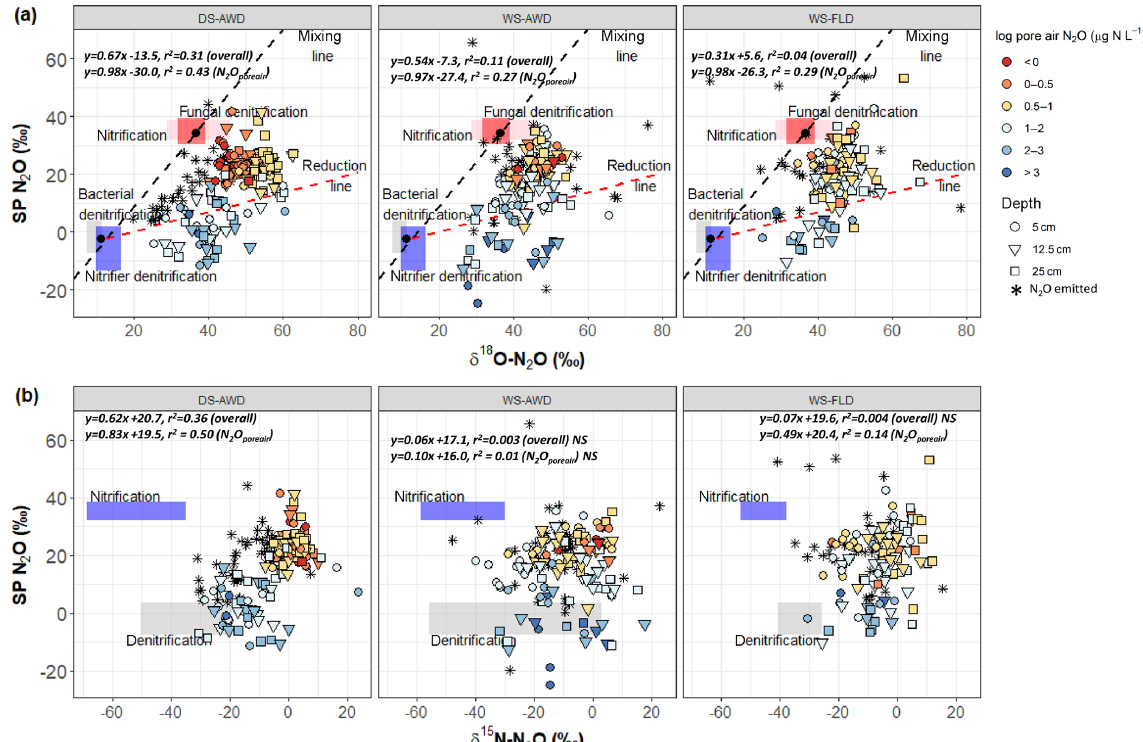
Figure 4. Graphical two end-member mixing plot after Lewicka-Szczebak et al. (2017) where sample values are plotted in SP × δ 18 O − N 2 O space A and two-end mixing plot after Toyoda et al. (2011) where sample values are plotted in SP × δ 15 N-N 2 O space B. In panel (a) the black dots indicate the mean literature end-member values used in our modeling scenarios and the boxes represent a range of values derived from the literature attributed to each process; see Sect. 2.7 and Table 2. To calculate the range of N 2 O potentially produced by nitrification or denitrification in (b) , we used the mean isotope effects, ε 15 N N and ε 15 N N , reported in Denk et al. (2017) to represent 2 O / NO 3 2 O / NH 4 denitrification and nitrification derived N 2 O, respectively, and then added the minimum and maximum δ 15 N-NO − and δ 15 N-NH + values 3 4 observed in each treatment (Table S1.4). The linear relationship between each isotope pair is indicated in italics for all points together and for N 2 O poreair only. The three water management treatments were as follows: WS-FLD – water-seeding + conventional flooding; WS-AWD